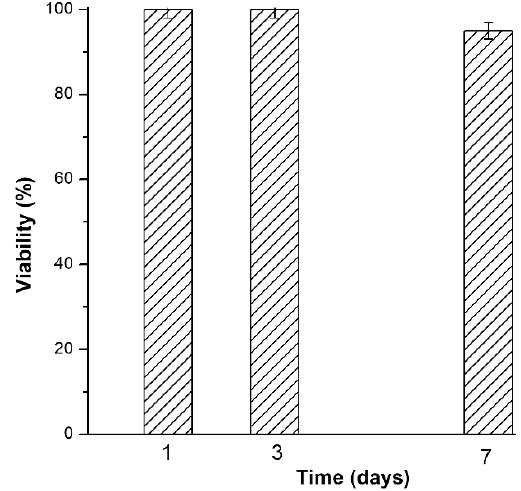
Nanomaterials 2019 , 9 , x FOR PEER REVIEW 15 of 19 Figure 12. Cytotoxicity test results. SaOs2 cells labelled with both DAPI and Ki67 were counted. We performed five determinations for each sample and compared with the control (cells grown on borosilicate glass) (Figure 13). The data are expressed by: (number of Ki67 positive cells / number of cells labelled with DAPI) × 100.